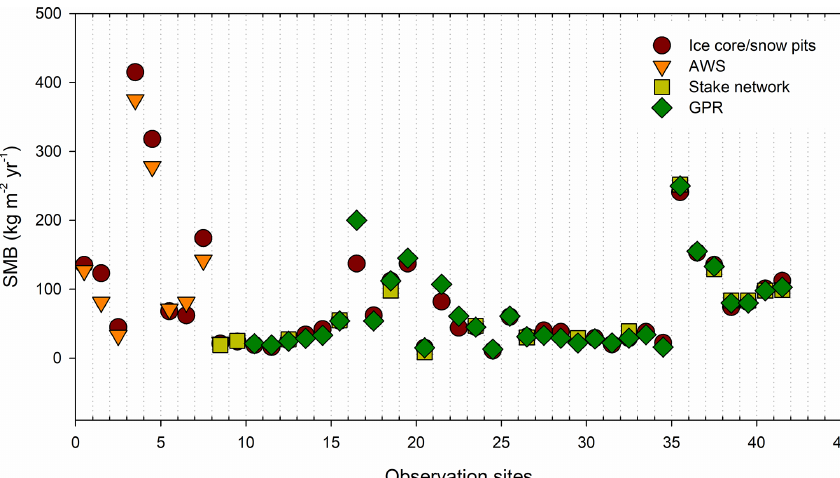
Figure 4. Inter-comparison between different types of SMB measurement including AWSs, snow pits/ice cores, and GPR at 42 locations. The measurements are mainly distributed near Talos Dome, along a transect from Terra Nova Bay to Dome C, on western Dronning Maud Land, and at Dome F and Dome